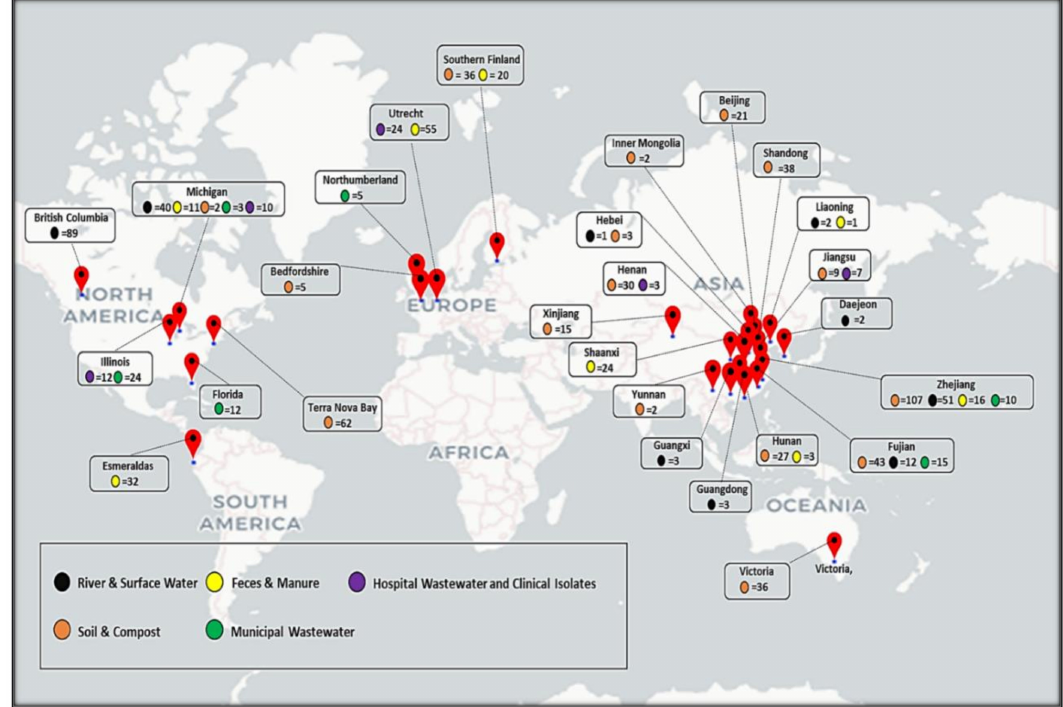
Figure 1. World map showing no. of samples of different environmental matrices analyzed by HT-qPCR over last 7 years in different regions of the